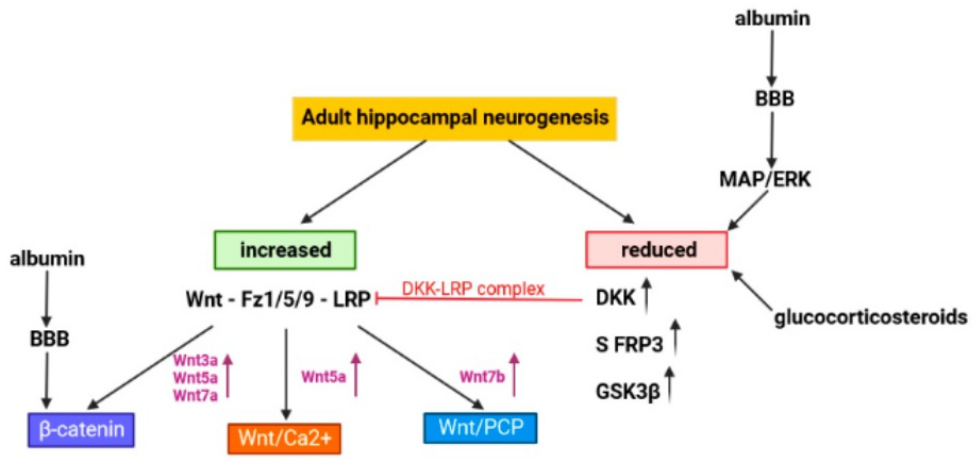
Figure 2. Strategies for influencing neurogenesis in the adult hippocampus based on the modulation of the Wnt signaling pathway ( The figure was made in Biorender ).